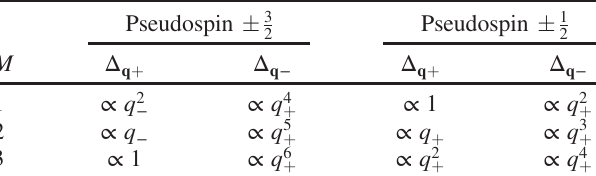
TABLE IV. Gap functions of odd-parity j J; M i pairing states. Leading-order expansions of the gap functions Δ chiral pairing states with M ¼ 1 , 2, 3 according to Eqs. (77) and (78) (and their equivalents for Δ q ¼ q x (cid:2) iq y . Also shown are the leading-order expansions (cid:2) of the gap functions for the case of a pseudospin (cid:2) 1 surface, i.e., the conduction band in our